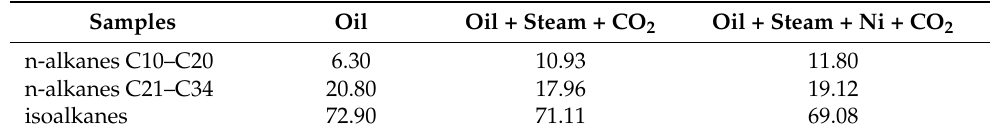
6 of 14 Figure 3. The chemical group composition of oil samples. 3.3. GC-MS Results of Saturates and Aromatics The GC-MS results of the saturated fractions isolated from the initial crude oil sam- ple, and after CO 2 -assisted hydrothermal treatment at 300 °C, in both the absence and the presence of nickel tallate, are presented in Table 2 and Figure 4. The relative content of C10 – C20 n-alkanes increased from 6.30% to 10.93% in the case of the noncatalytic upgrad- ing. The addition of the catalyst further increased this value by up to 11.8%. This is ex-